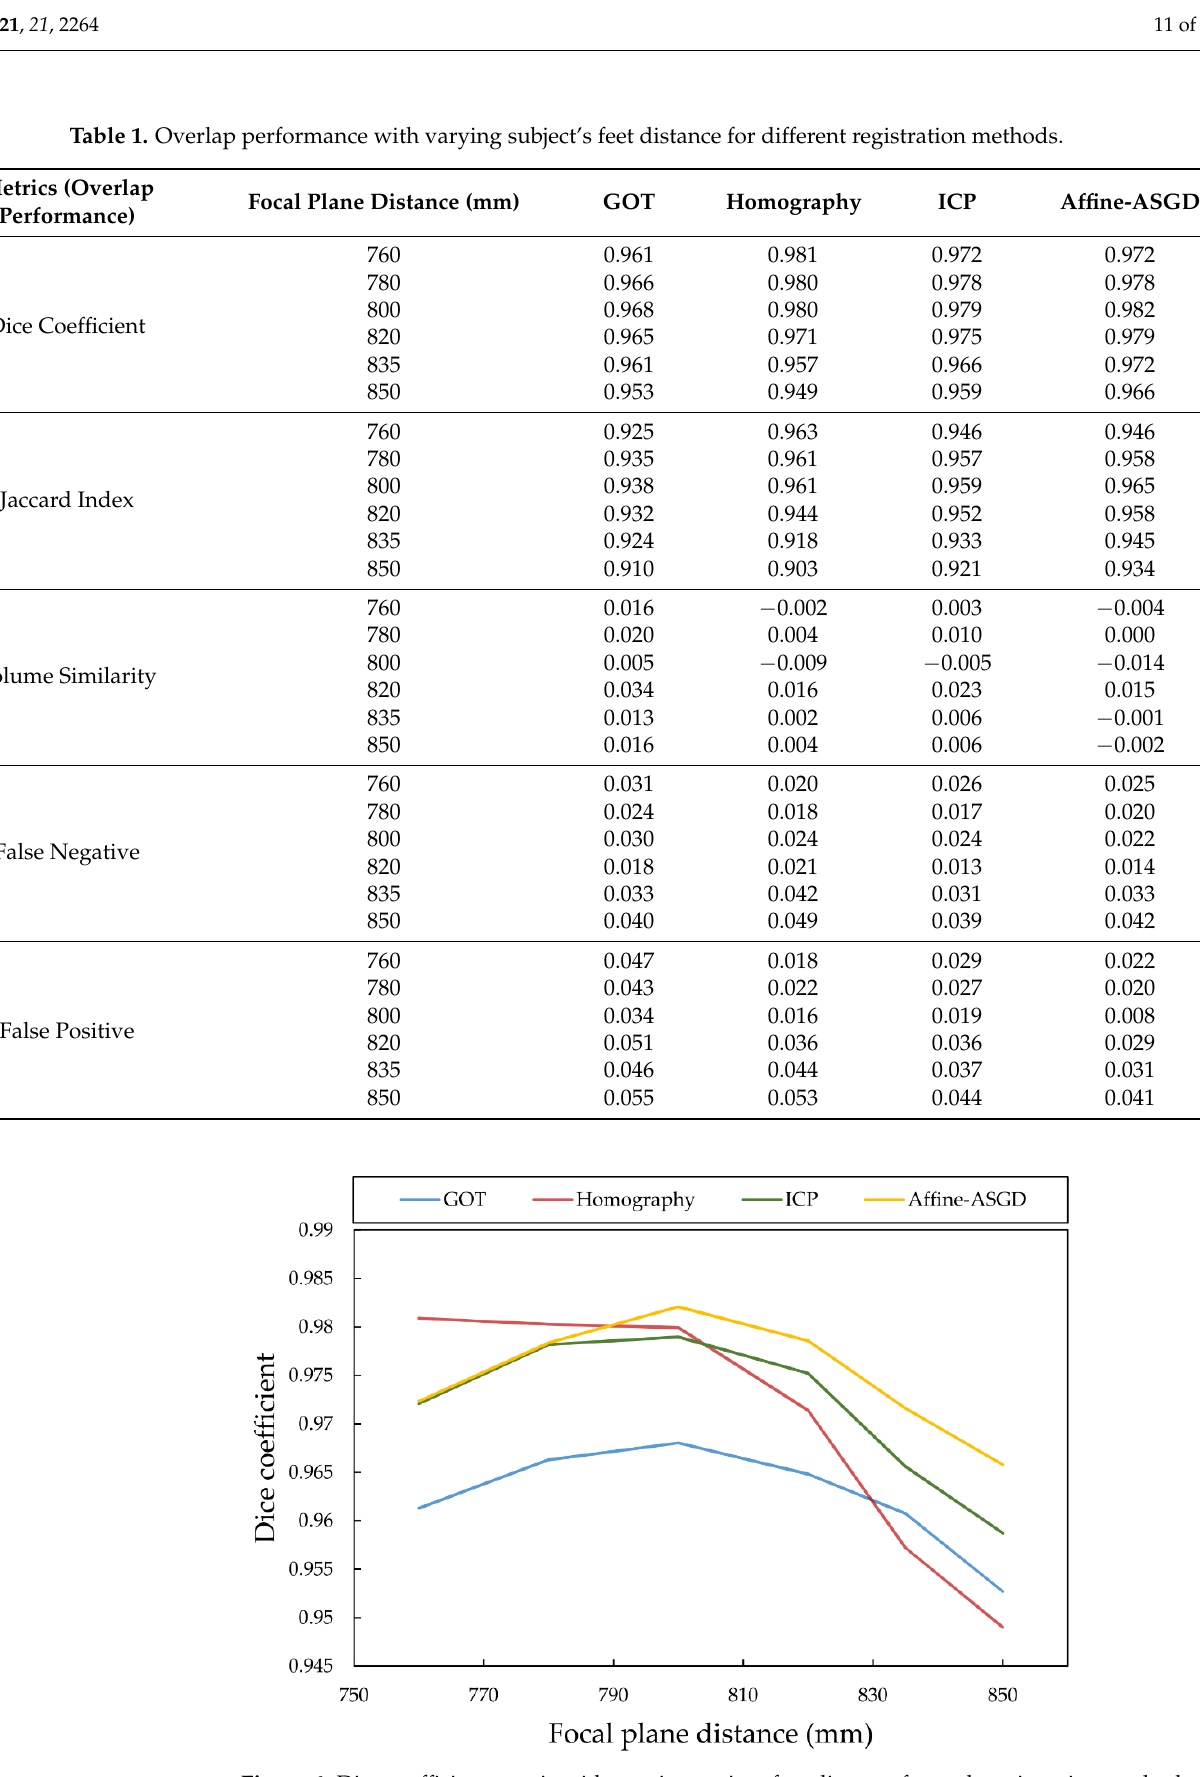
Figure 6. Dice coefficient metric with varying patient feet distance for each registration method.